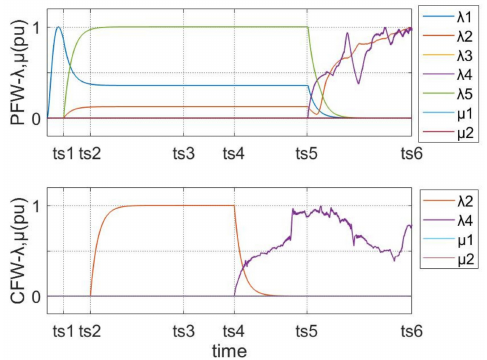
Figure 11. Multiplier. λ and µ .